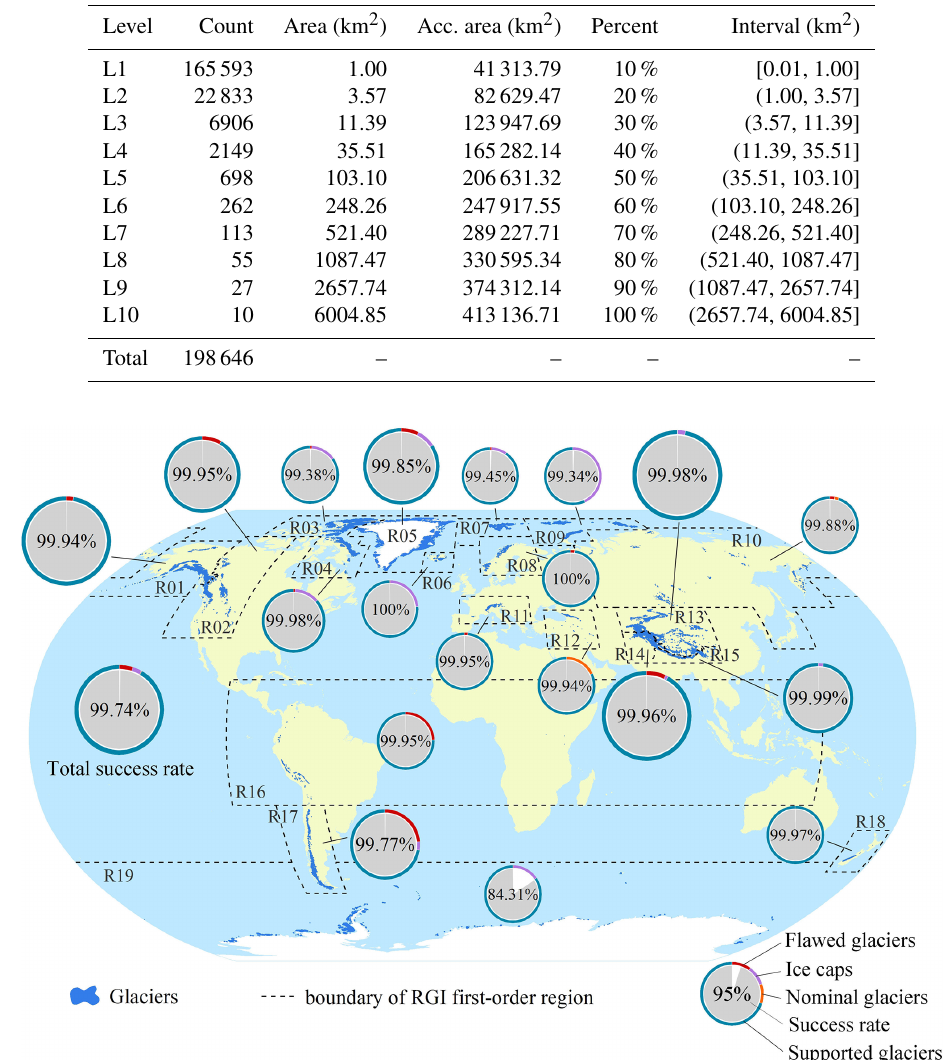
Figure 4. Extraction of glacier centerlines in different glacier regions. The pie charts indicate the proportions of input glaciers and of the three types of excluded glaciers in the region. The pie charts represent the correct rate, which is the proportion of correctly extracted glaciers. The size of the pie chart represents the grade of the glaciers in the